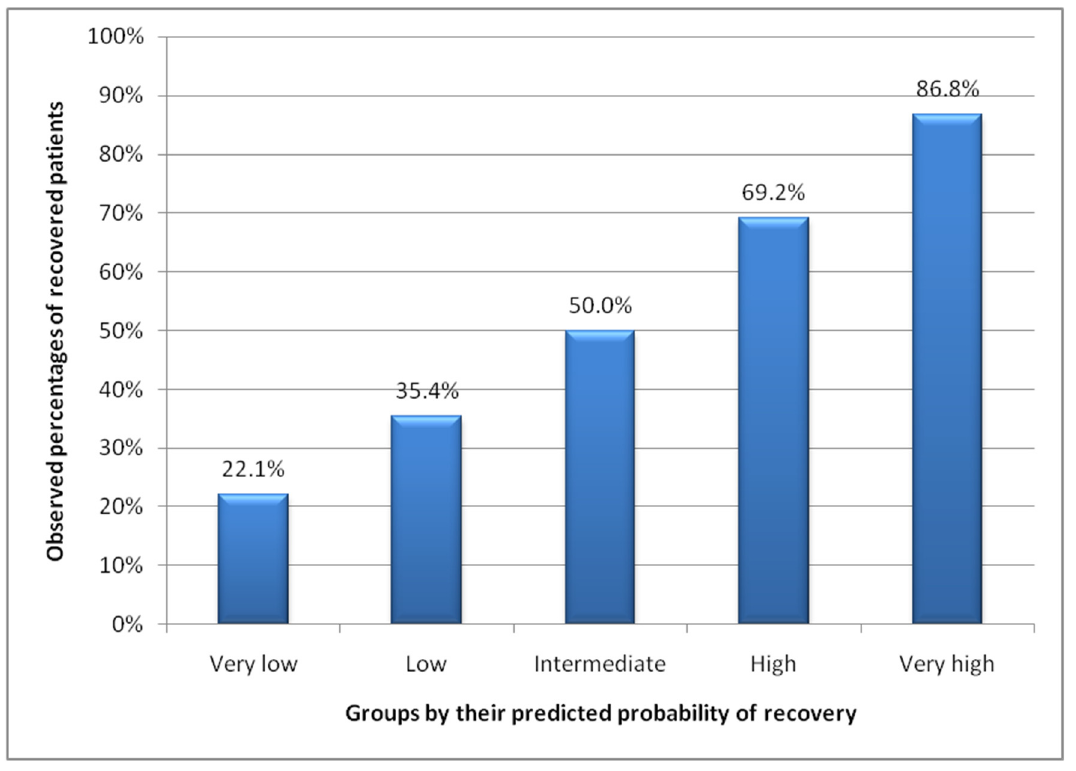
Figure 4. Rate of recovered patients within each group by their predicted probability of recovery.